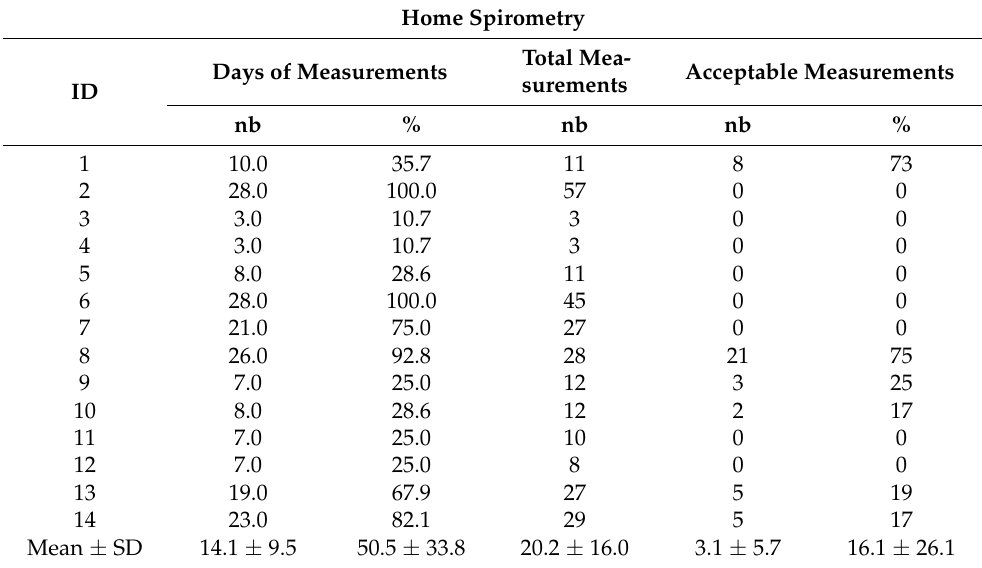
Table 2. The number of measurements of home spirometry for individual patients.